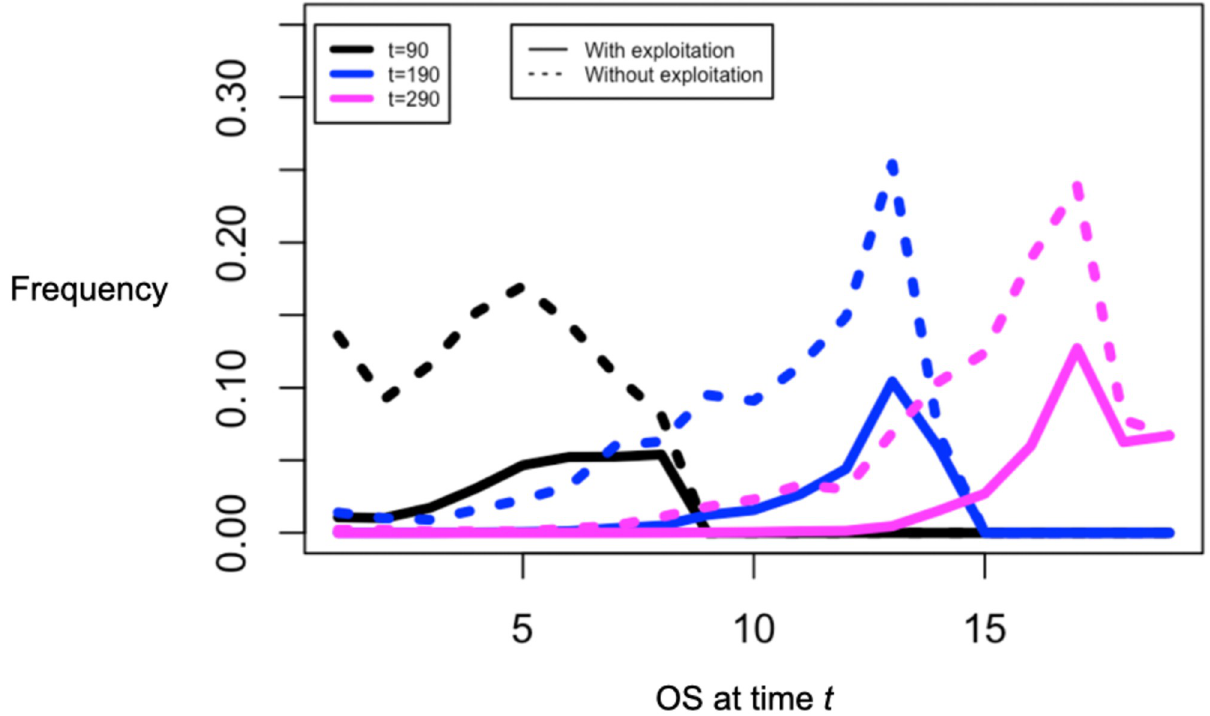
Fig 12. The distribution of OSs over time for θ = 0.025. We show the distribution of all OSs as a dotted line—- note the long left-hand—-tail and the distribution of unexploited OSs as a solid line. Because the stochastic process is right limited, the frequency distribution drops to zero for times at which an OS is not available (i.e., is 0 whenever t < t ). In addition, since older OSs are more likely to be exploited than more recent ones, the distribution of k unexploited OSs is more symmetrical than the distribution of all